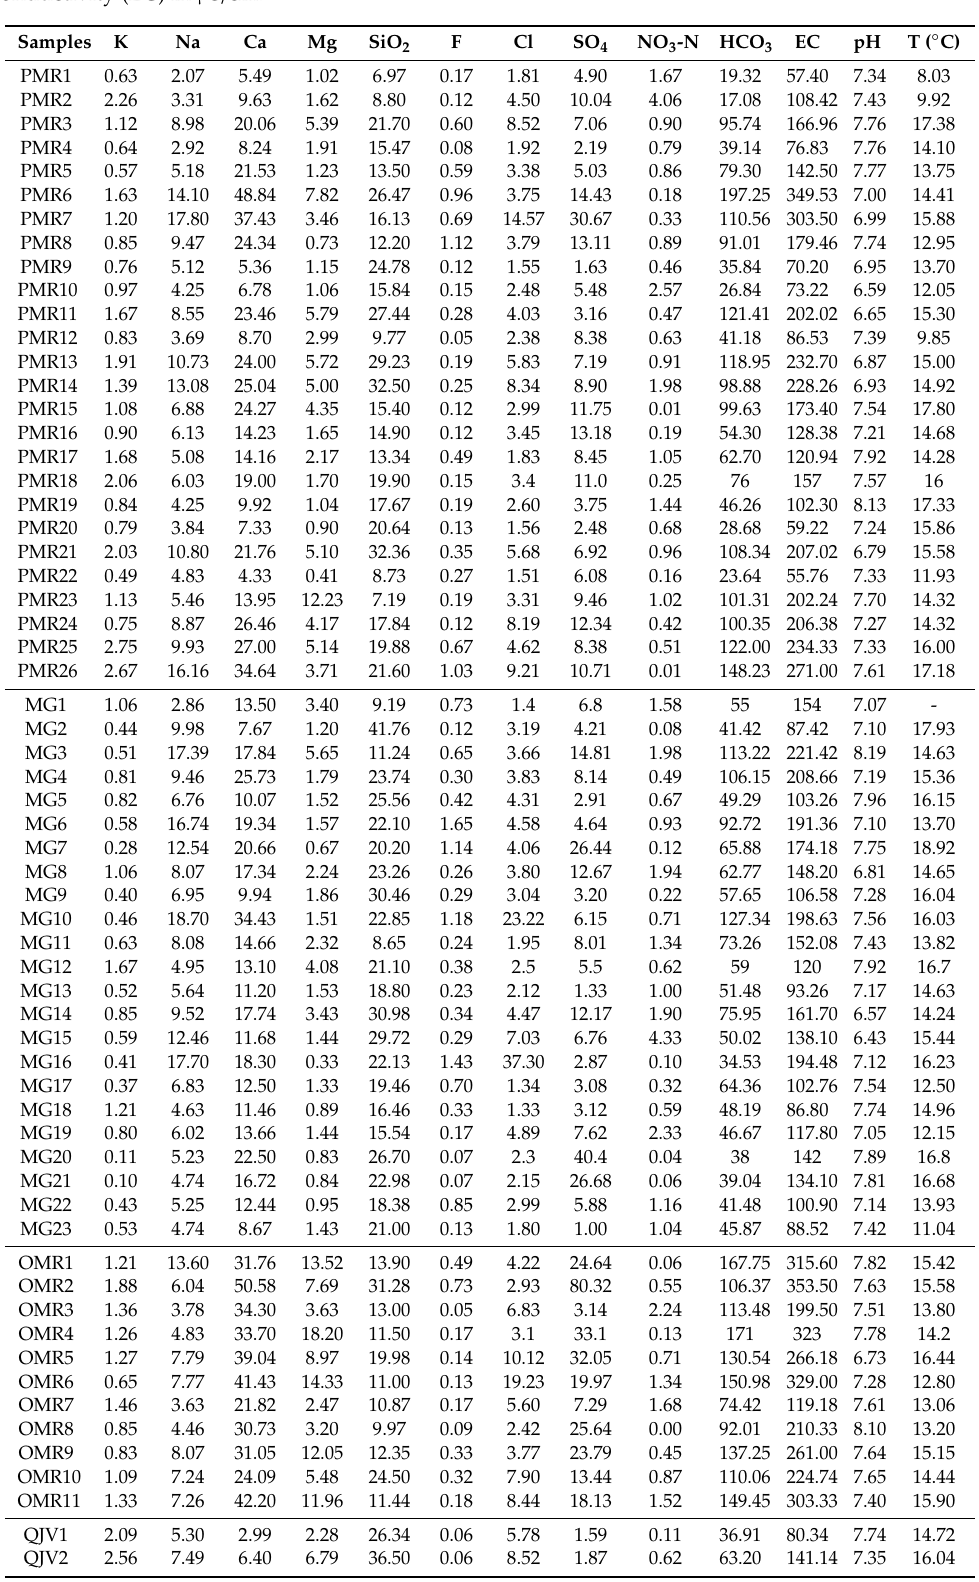
Table 1. Physicochemical compositions of groundwater for mineral waters for di ff erent types of rocks (PMR: Precambrian metamorphic rocks, MG: Mesozoic granite, OMR: Ogcheon metamorphic rocks, OJV: Quaternary Jeju volcanic rocks). Concentration unit is mg / L unless otherwise noted. Electrical conductivity (EC) in µ S /